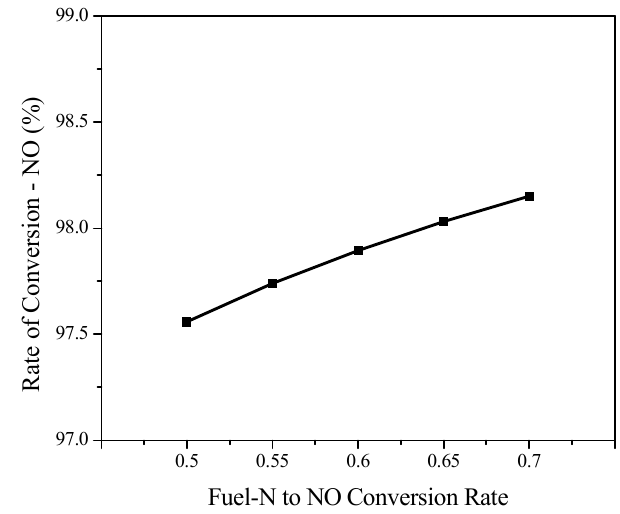
Figure 6. Profile of fuel N to NO conversion versus NO Conversion (%) in pressurized reactive distillation column (PRDC).